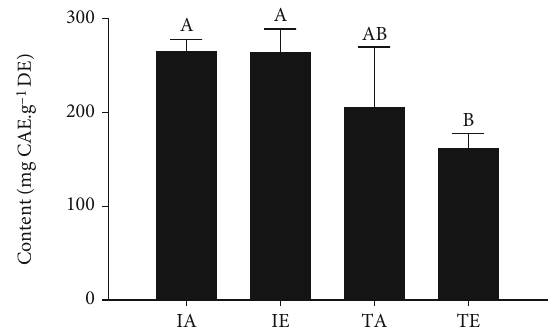
Figure 1: Total phenolic content by Folin-Ciocalteu assay. Di ff erent letters (A, B) indicate signi fi cant di ff erence (ANOVA, followed by Tukey test; p < 0 : 05 ). IA: aqueous infusion; IE: hydroethanolic infusion; TA: aqueous turboextraction; TE: hydroethanolic